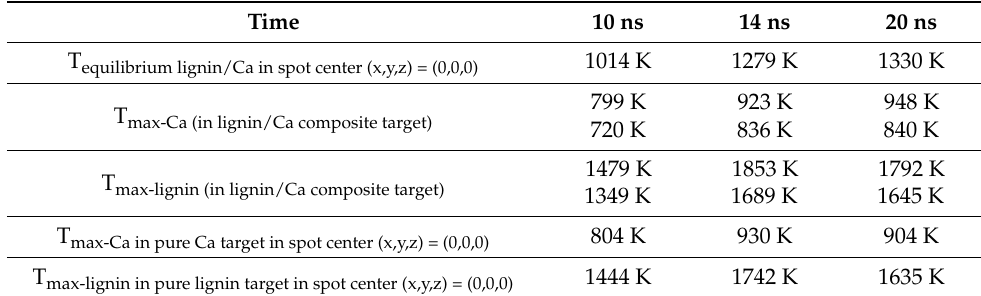
Table 2. Compared maximum temperatures developed on Ca in the lignin/Ca composite at different times compared to temperatures in pure Ca at different times.